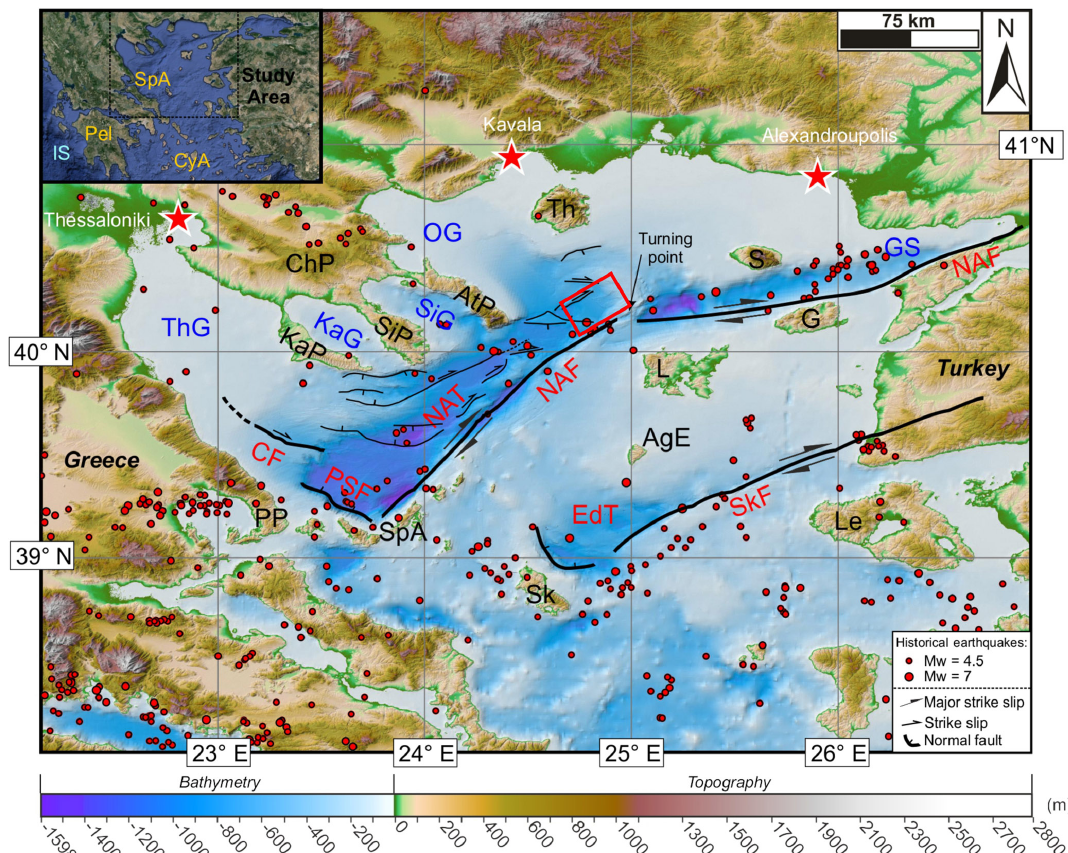
Figure 1. General morphological features of the studied area. The main faults are indicated (after Sakellariou and Tsampouraki-Kraounaki, 2016). Seismicity since 1 January 1950 is taken from USGS for earthquakes with M w > 4 . 5. The red rectangle gives the location of the Thasos landslide. In the inset is the location of the study area (background from Google Earth). AgE is Agios Efstratios, AS is Aegean Sea, AtP is Athos peninsula, ChP is Chalkidiki peninsula, CyA is Cyclades archipelago, EdT is Edremit Trough, G is Gokceada (Imbros), GS is Gulf of Saros, IS is Ionian Sea, KaG is Kassandra Gulf, KaP is Kassandra peninsula, L is Lemnos, Le is Lesbos, NAT is North Aegean Trough, NAF is North Anatolian Fault, OG is Gulf of Orfani, Pel is Peloponnese, PP is Pelion peninsula, PSF is Pelion–Skopelos Fault, S is Samothrace, SiG is Sigitikos Gulf, SiP is Sithonia peninsula, Sk is Skyros, SkF is Skyros Fault, SpA is Sporades archipelago and Th is Thasos, ThG is Thermaic Gulf. General topography and bathymetry from SRTM30 (Becker et al., 2009) and high-resolution bathymetry (250m) are from Sakellariou and Tsampouraki-Kraounaki (2016).